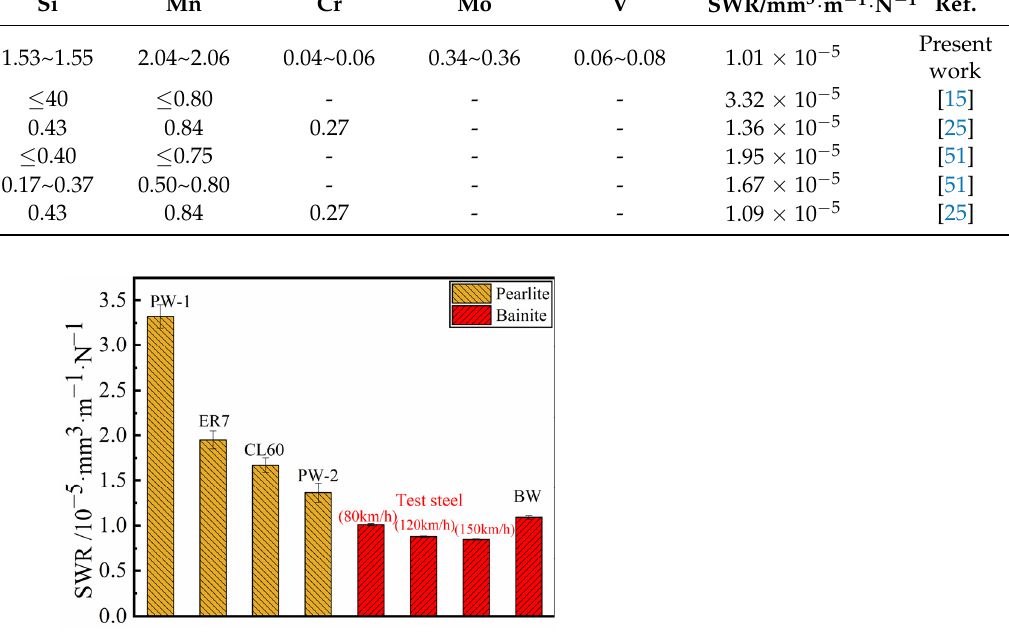
Figure 12. The comparison of the wear-resistance of the test steel and reported representative wheel material.